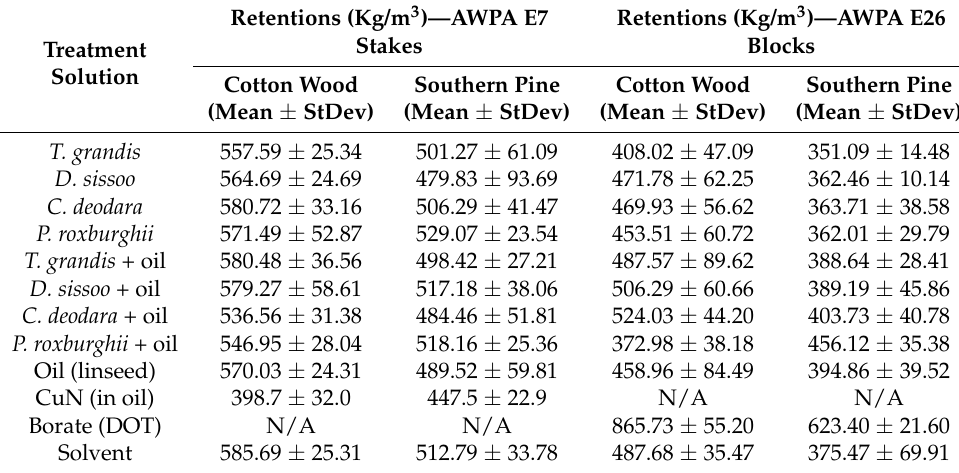
Table 1. Retention of treatment solutions in southern pine and cottonwood.